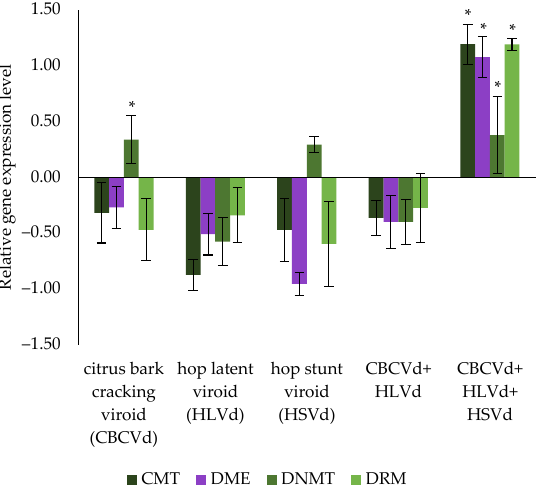
Figure 4. Differential gene expression of the newly identified CMT, DME, DNTM, and DRM in hop’s draft genome, across hop plants infected with different viroids and their combination (CBCVd, HLVd, HSVd, CBCVd and HLVd, and CBCVd, HLVd, and HSVd) compared with viroid-free hop plants. An asterisk indicates a statistically significant result ( p -value < 0.05), and the bars show the standard errors.